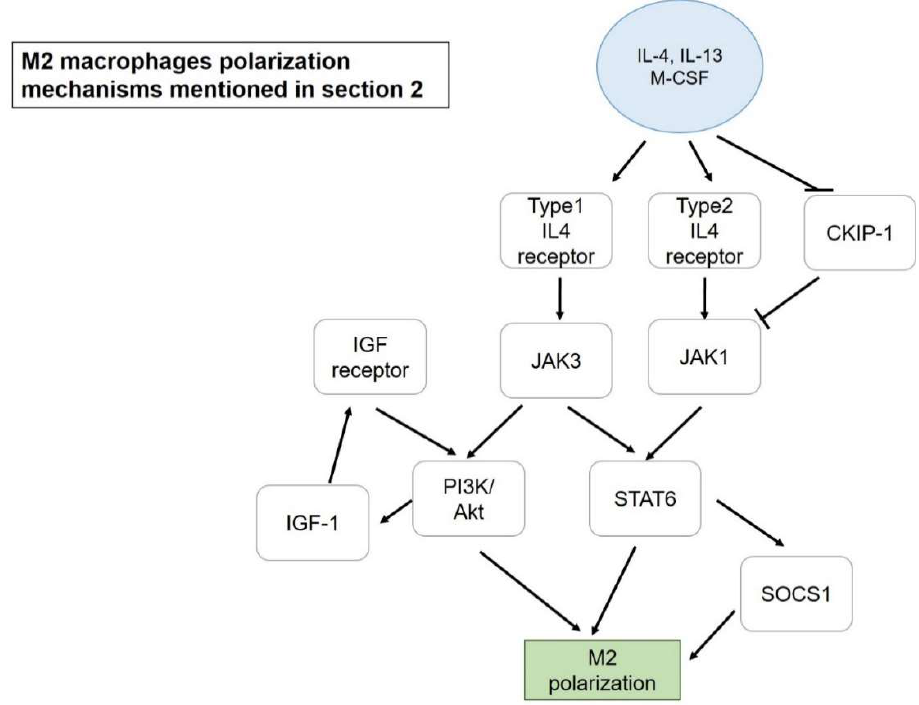
Figure 2. M2 macrophage polarization mechanisms mentioned in Section 2. Blue circle, inducers; white blocks, genes/proteins involved.